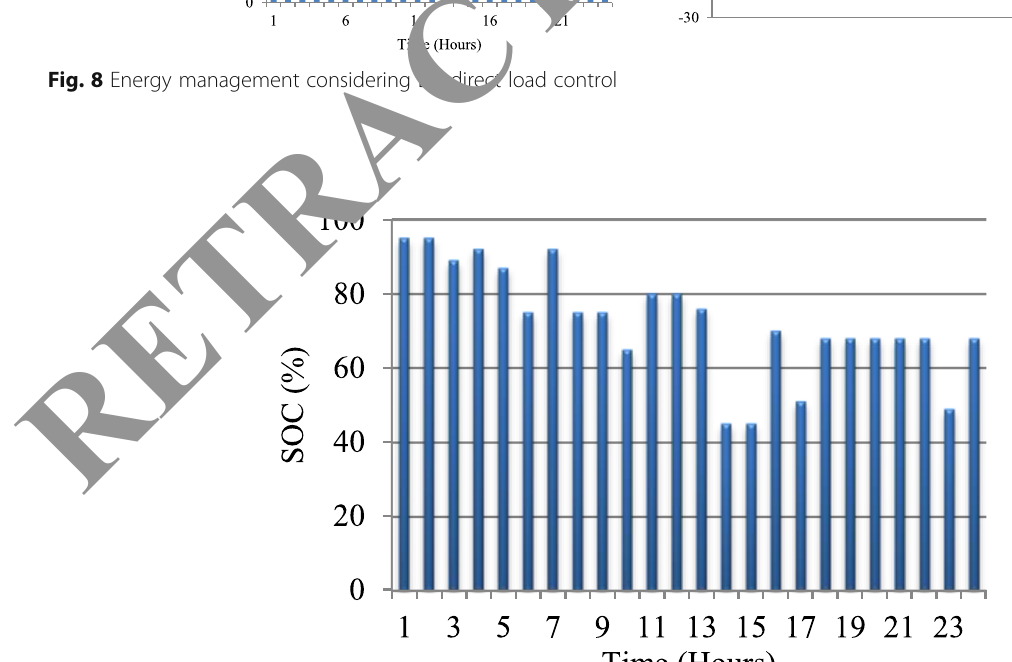
Fig. 8 Energy management considering DR direct load control